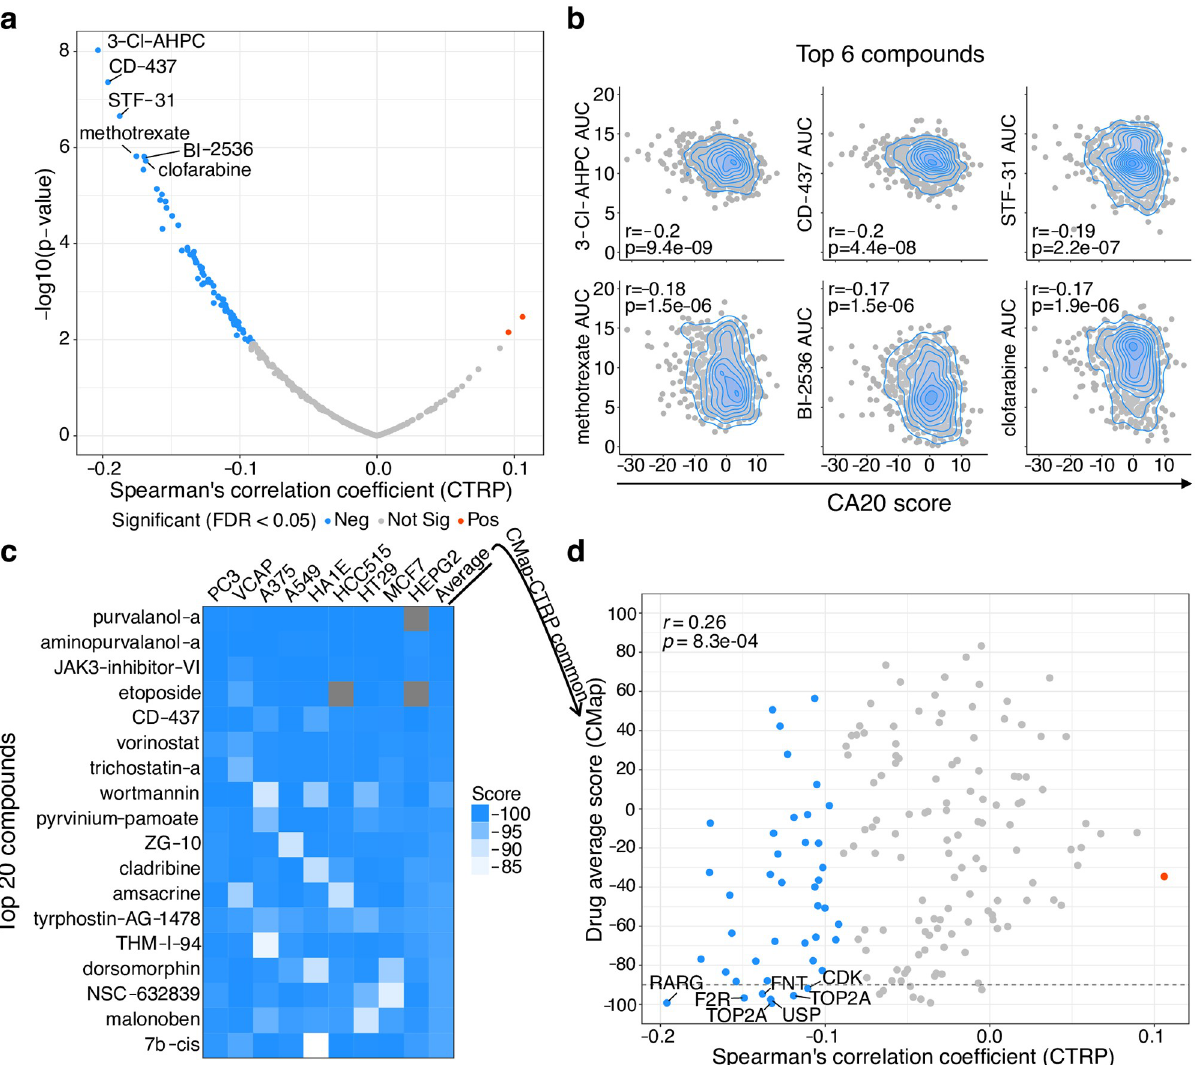
Fig 6. Identification of compounds that selectively kill cancer cells with high CA20. ( a ) Compounds with selective activity on cell lines with high or low CA20 score. The volcano plot shows the results of Spearman’s correlation analyses between CA20 scores and compound Area Under the dose- response Curve (AUC) across Cancer Therapeutics Response Portal (CTRP) human cancer cell lines. Note that lower AUC means higher drug activity. The compounds whose activity was associated with high and low CA20 (FDR < 0.05) are represented in blue and red, respectively. The top 6 compounds are highlighted. ( b ) Top 6 compounds targeting cells with higher CA20 score. Smooth scatter plots showing correlation between CA20 score and compound AUC across CTRP cell lines for the top 6 compounds from (a). Spearman’s correlation coefficients, r, and respective p-values are shown. ( c ) Compounds that down-regulate the CA20 gene set. Heatmap of CMap’s drug score, ranging from 100 (maximum CA20 up-regulation) to -100 (maximum CA20 down-regulation) per cell line. Drug average score (last column) is the mean of drug scores across cell lines. The 20 compounds with the lowest drug average score are shown and ranked accordingly. Tissue of origin of human cancer cell lines: PC3: prostate; VCAP: prostate; A375: melanoma; A549: lung; HA1E: kidney; HCC515: lung; HT29: colon; MCF7: breast; HEPG2: liver. ( d ) Compounds selectively targeting cells with higher CA20 also down-regulate these genes. Scatter plot showing correlation between CTRP’s Spearman’s correlation coefficient from (a) and CMap’s drug average score from (c) for the 164 compounds tested in both datasets (Spearman’s correlation coefficient, r = 0.26, p-value = 8.3e-4). Points are coloured as in (a) and the predicted protein targets of compounds with both significant Spearman’s correlations and drug average score lower than -90 are shown.